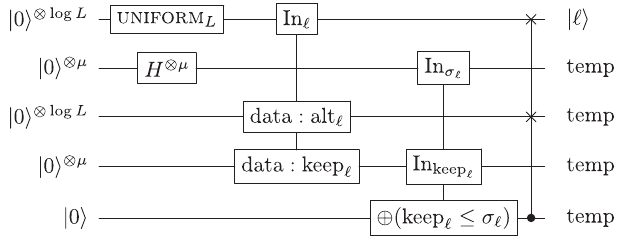
FIG. 11. Generic SUBPREPARE circuit for initializing an arbi- trary state with L unique amplitudes. It spans 2 μ þ 2 log L þ O ð 1 Þ qubits and has a T count of 4 ð L þ μ Þ þ O ð log L Þ , where μ is calculated as in Eq. (36). Produces a state